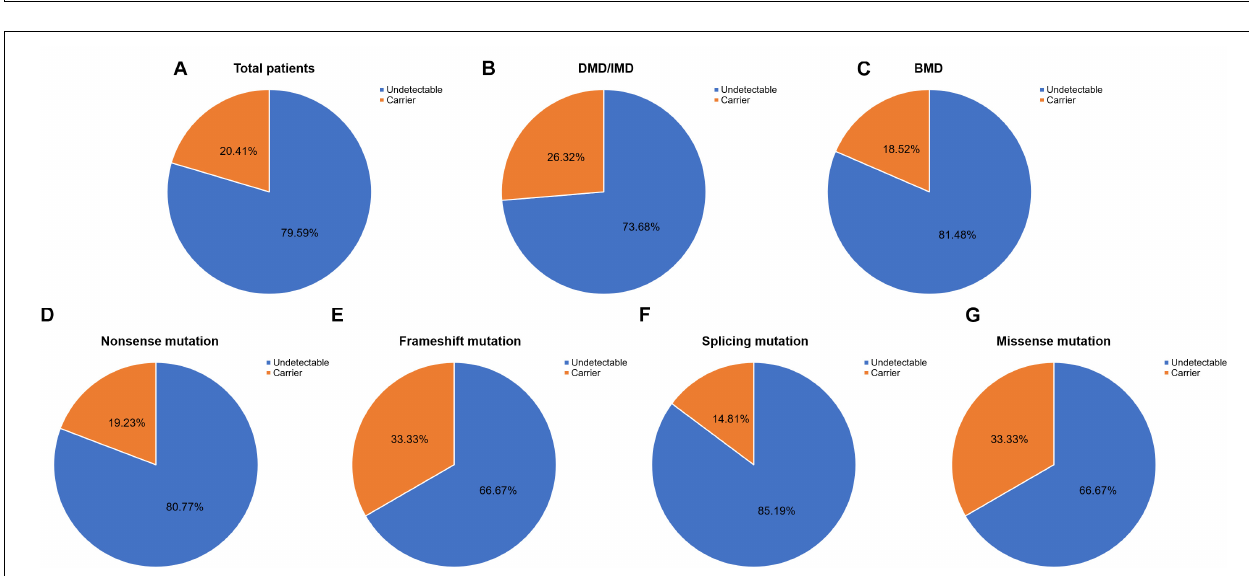
FIGURE 1 | Distribution of mutation types. The ratios of mutation types in (A) all patients, (B) DMD/IMD, and (C) BMD.